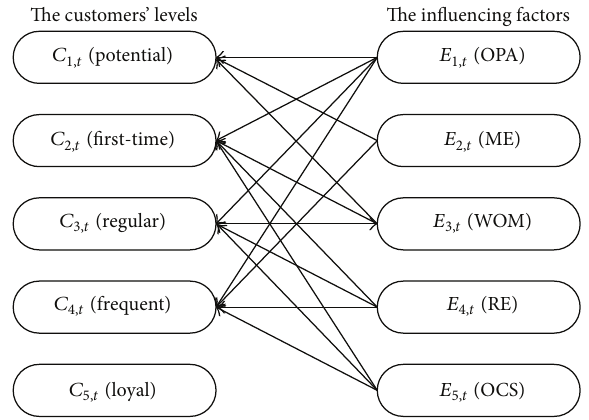
Figure 5: The relationships between customers’ levels and influenc- ing factors.